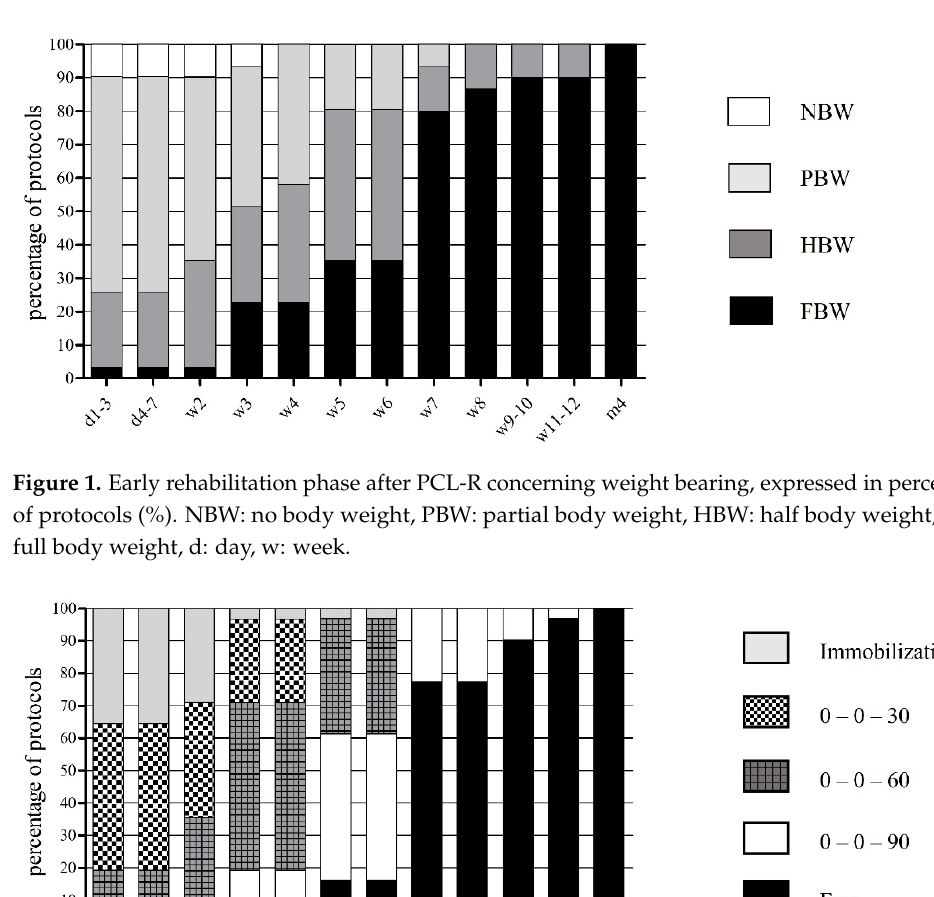
Figure 1. Early rehabilitation phase after PCL-R concerning weight bearing, expressed in percentage of protocols (%). NBW: no body weight, PBW: partial body weight, HBW: half body weight, FBW: full body weight, d: day, w: week.